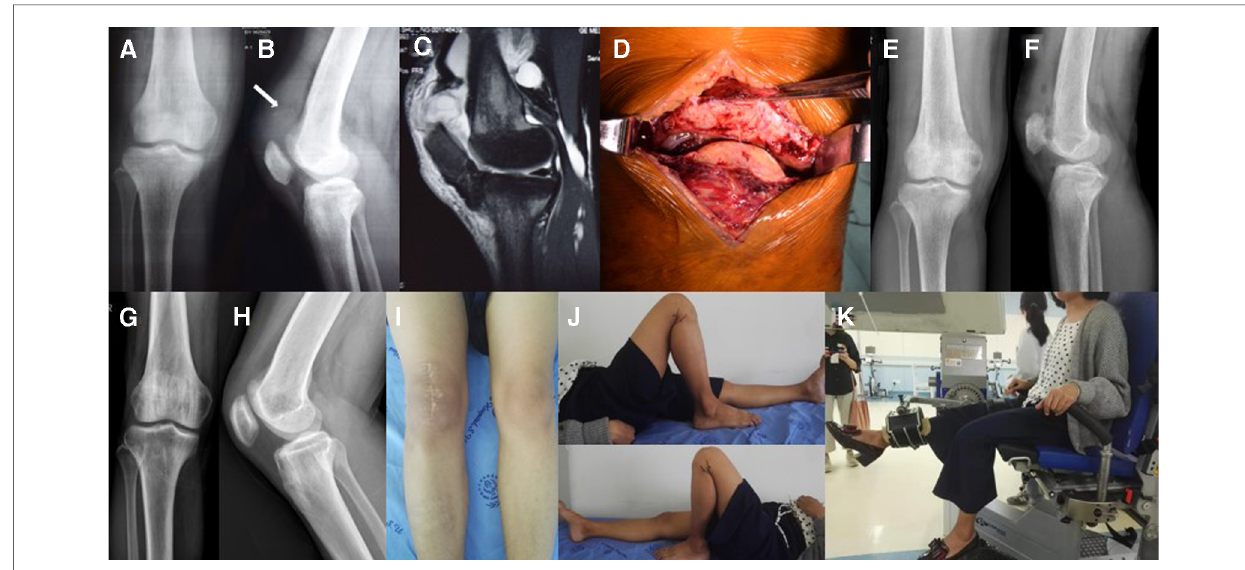
FIGURE 2 ( A ) x-ray of the right knee taken at the initial consultation showing severe osteoporosis. ( B ) Lateral radiograph showing the patella baja and calci fi cation in the ruptured end of the QT (arrow). ( C ) Lateral T2-weighted MRI of the right knee showing a complete disruption of the QT at the patellar insertion sites. ( D ) The QT peel off from the upper pole of the patella. ( E,F ) Radiography after QT repair showing the regular positioning of the patella. ( G,H ) Radiography one year after PTX showed BMD had signi fi cantly increase compared to pre-PTX levels. ( I,J ) One year after PTX, the ROM of the right knee was 0 – 130° and in the left knee was 0 – 140°. ( K ) The patient undergoing IMS tests.